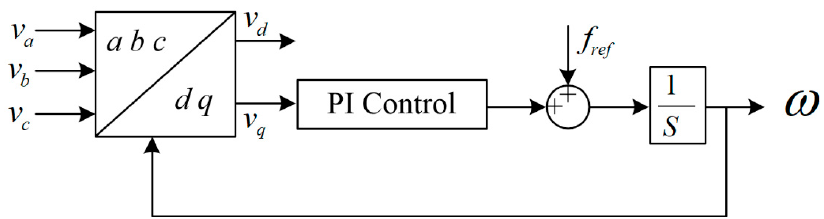
Figure 4. Layout of synchronous reference frame phase-locked loop.